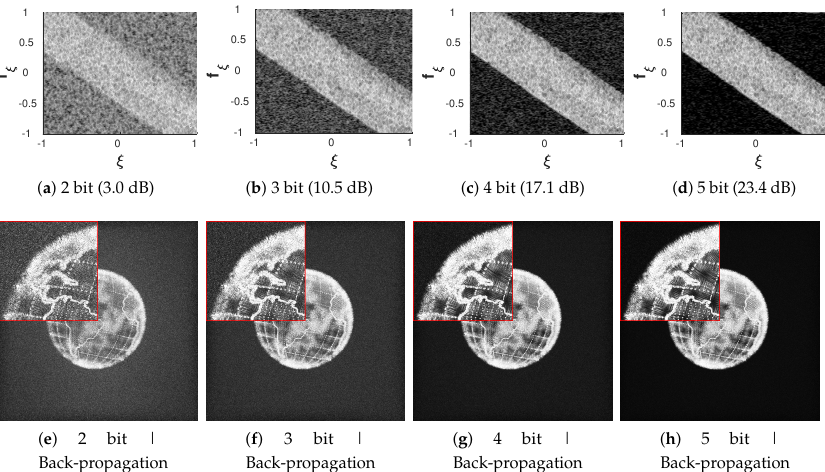
Figure 10. Top: Phase space visualization of the error introduced in Figure 9c by uniform quantization with various bit-depths per real/imaginary part. In brackets the signal-to-noise ratios of the quantized holograms are provided. Bottom: Corresponding back-propagations using the same parameters as in Figure 9a. The dynamic range was halved to enhance contrast.